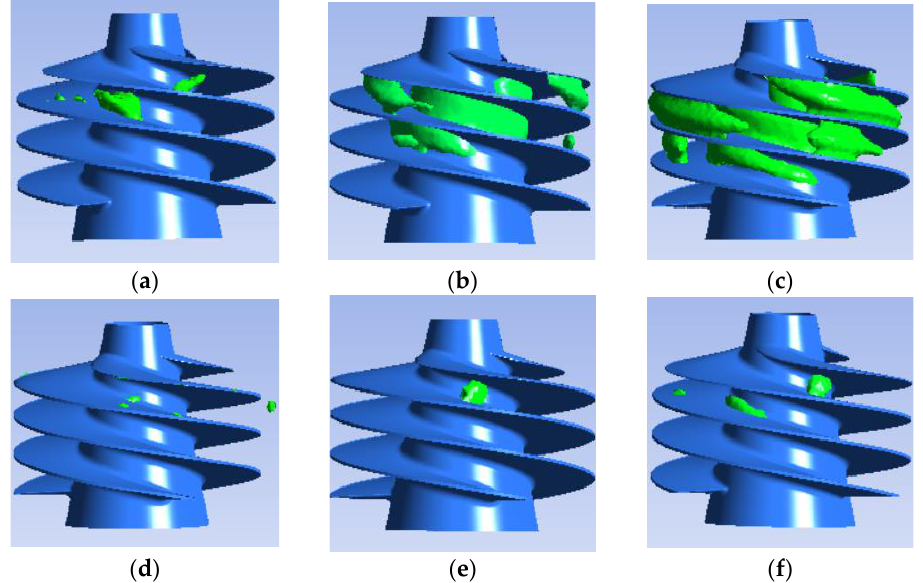
Figure 13. Iso-surface cloud diagram of the liquid oxygen vapor volume fraction of two different Zwart models at three temperatures; ( a ) Iso-Zwart T = 86 K; ( b ) Iso-Zwart T = 90 K; ( c ) Iso-Zwart T = 95 K; ( d ) Mod-Zwart T = 86 K; ( e ) Mod-Zwart T = 90 K; ( f ) Mod-Zwart T = 95 K.